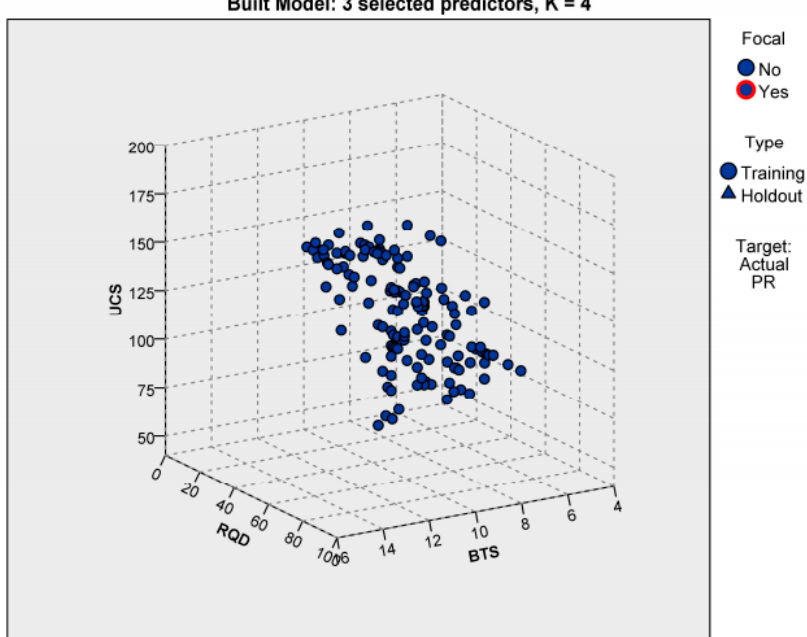
Figure 6. Predictor space chart of k-nearest neighbor (KNN) model.